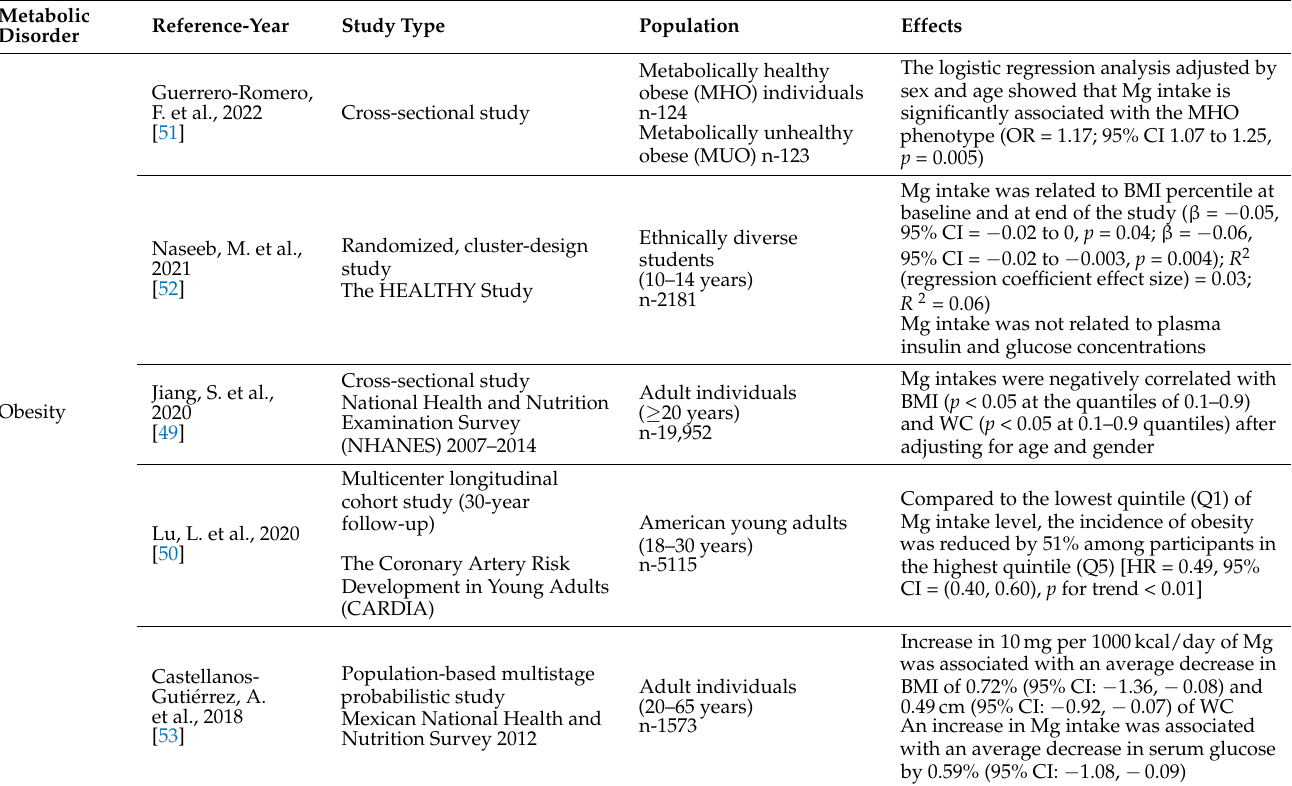
Table 3. Dietary magnesium intake and selected metabolic